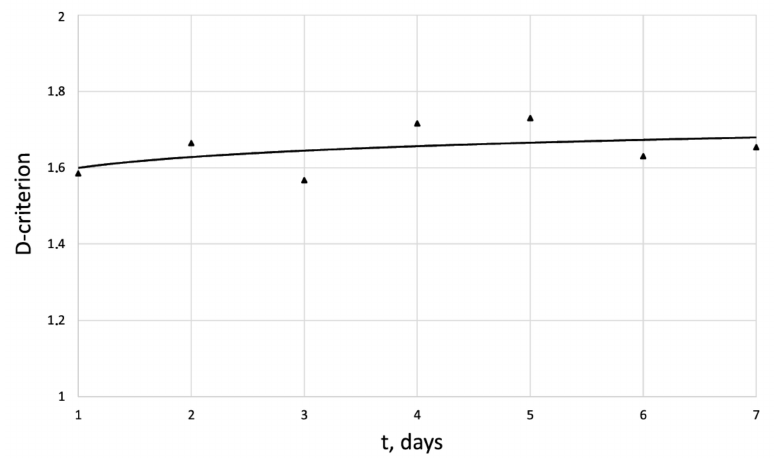
Figure 8. Dynamics of D -criterion for the human dermal fibroblast under pulsed electromagnetic exposure E = 500